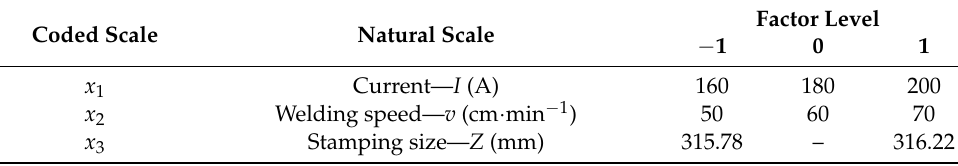
Table 4. Levels of observed factors.